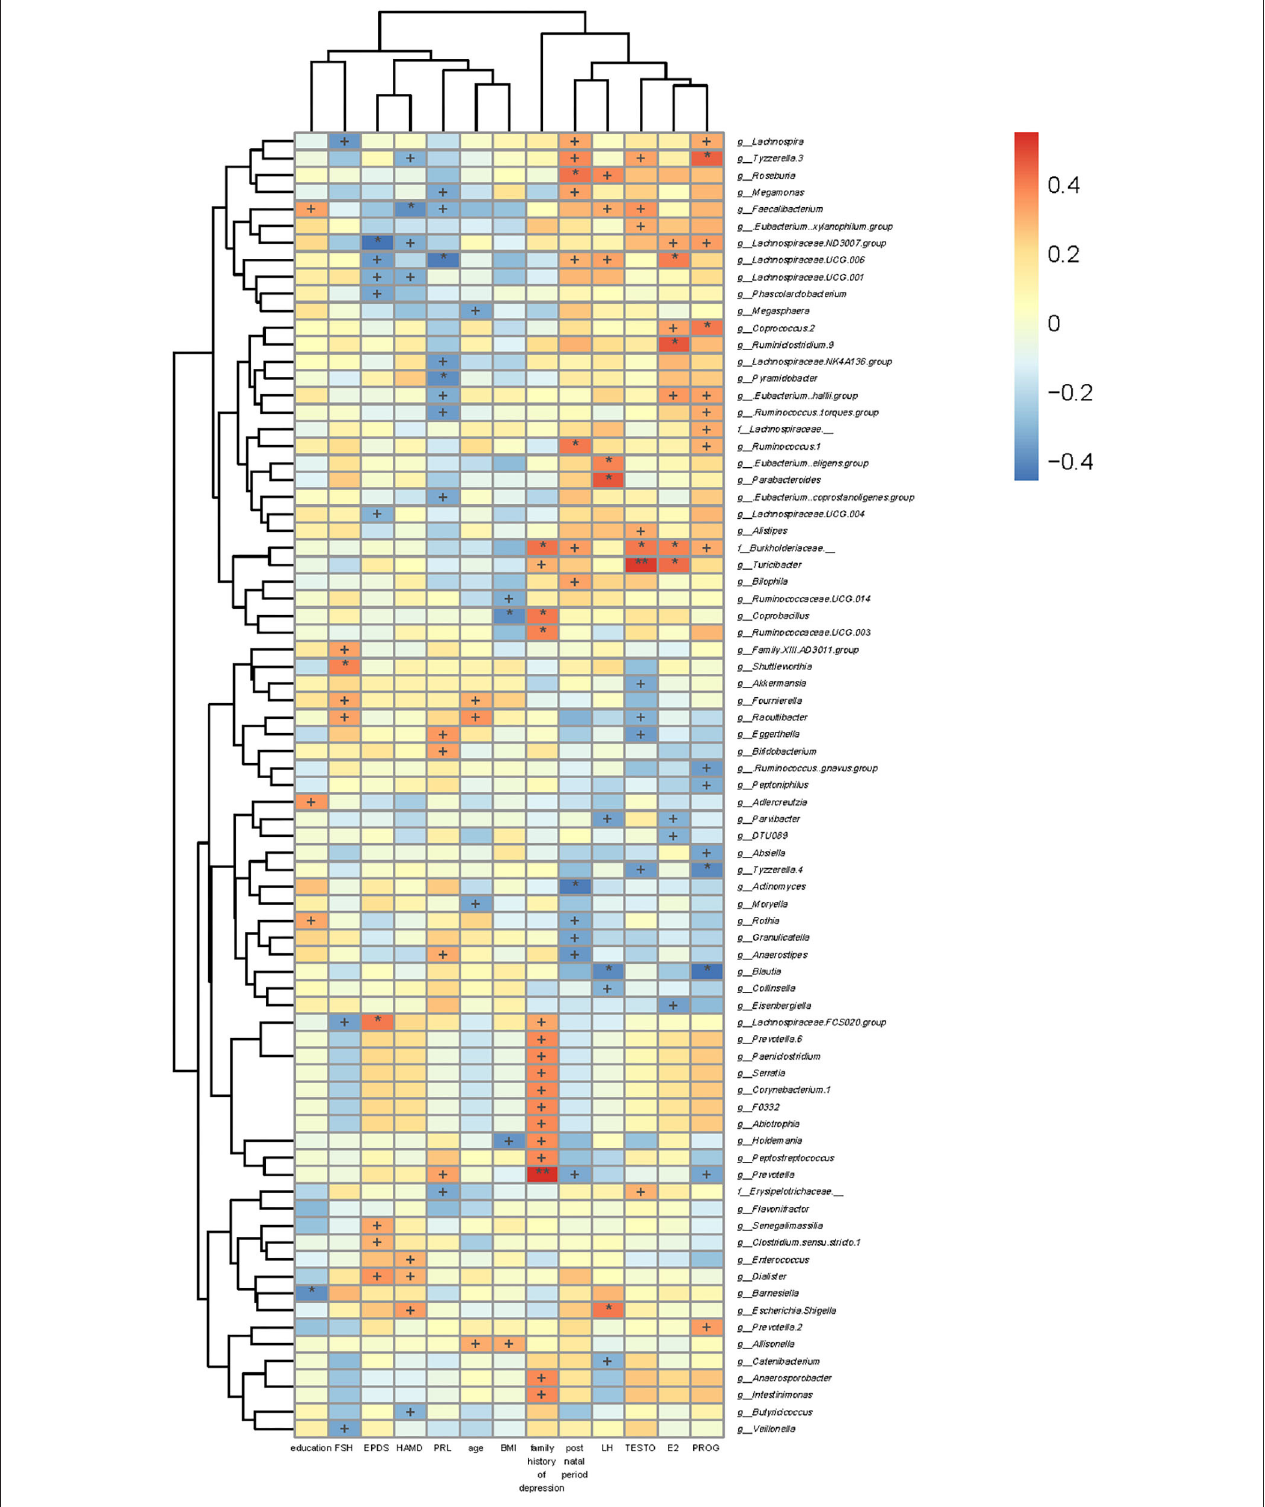
FIGURE 6 | Association of gut microbiota with clinical indicators. The heat map of Spearman’s rank correlation coefficients between the gut microbiota and clinical indicators. + P < 0.05; * P < 0.01; ** P < 0.001.